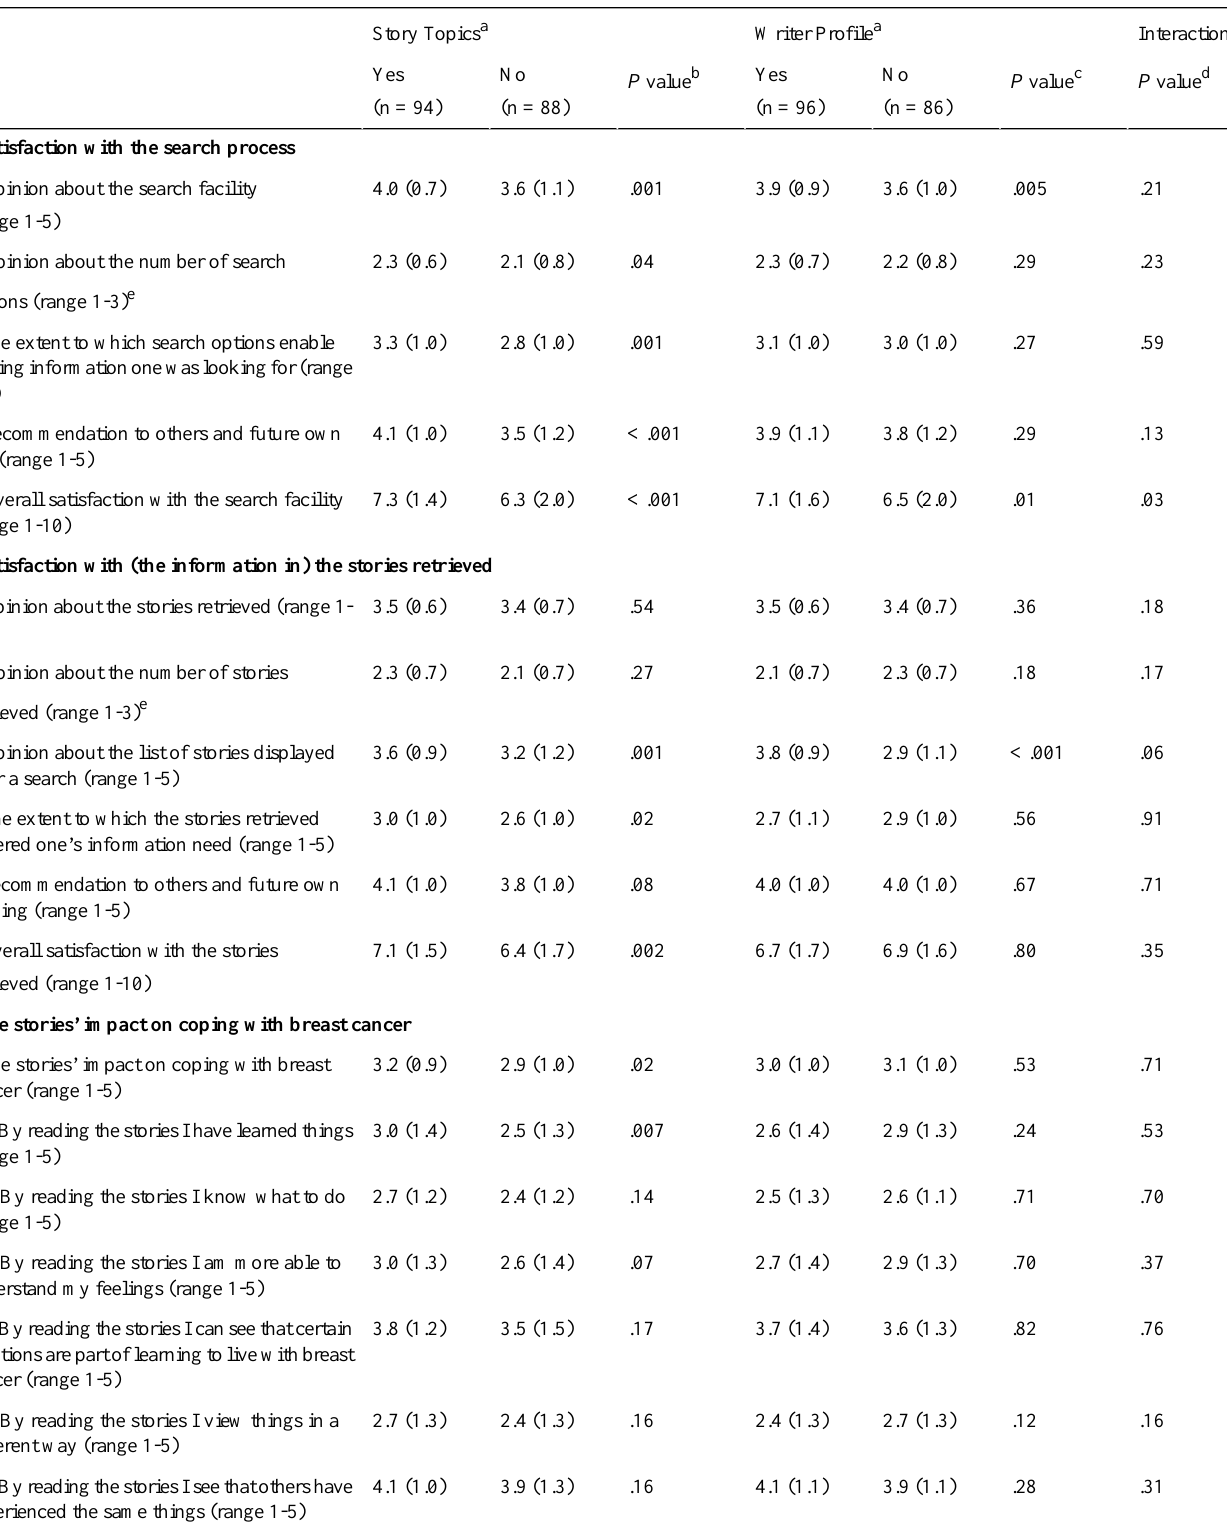
Table 5. Means (SD) of the constructs of the three outcome measures asked for in the final questionnaire by search